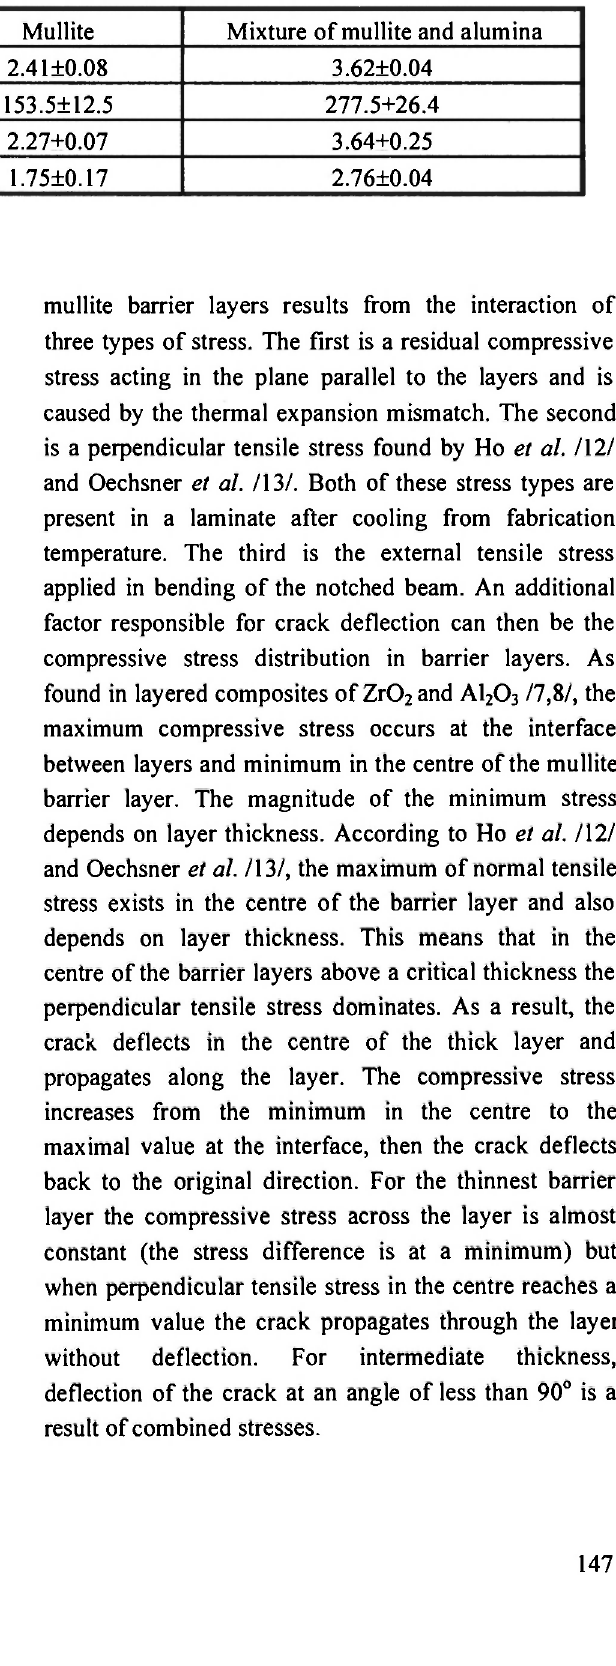
Mechanical properties of alumina, mullite and a mixture of mullite and alumina